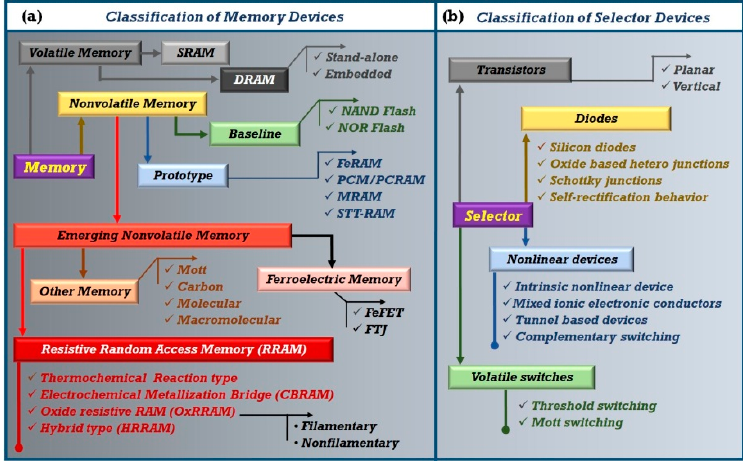
Figure 1. Schematic illustration of the ( a ) classification of memory devices and ( b ) classification of selector devices.